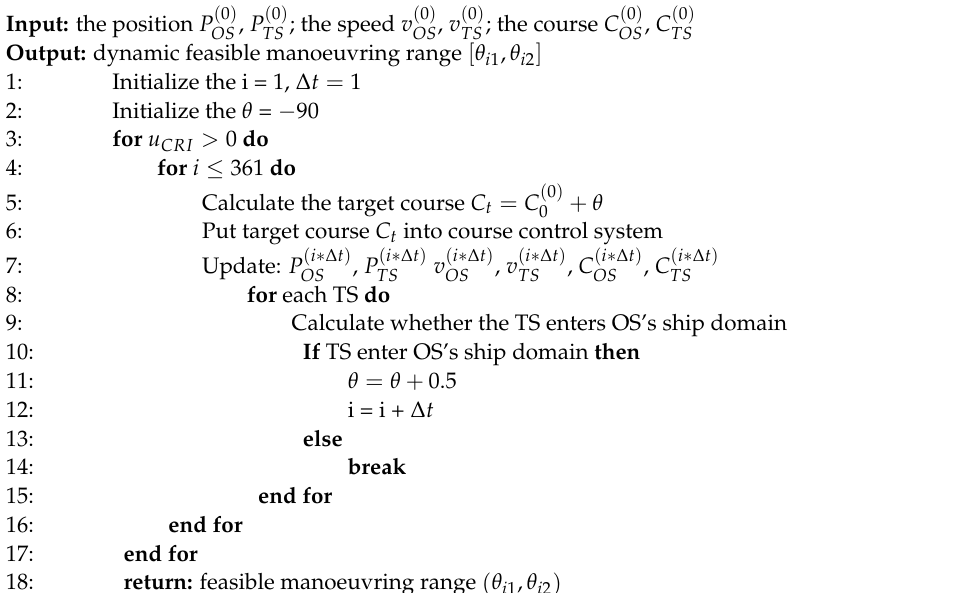
Algorithm 1. Algorithm for calculating dynamic feasible manoeuvring